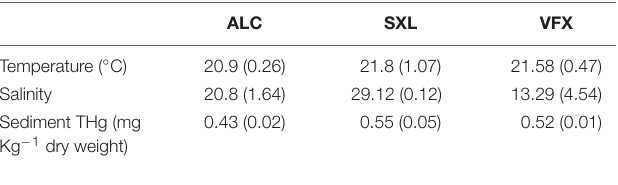
TABLE 1 | Mean (and standard deviation) salinity and temperature measured in each site of the Tejo estuary surveys (ALC, SXL, and VFX); and total mercury concentration (and standard deviation) in the sediment (top 5–8 cm layer) (sediment THg).